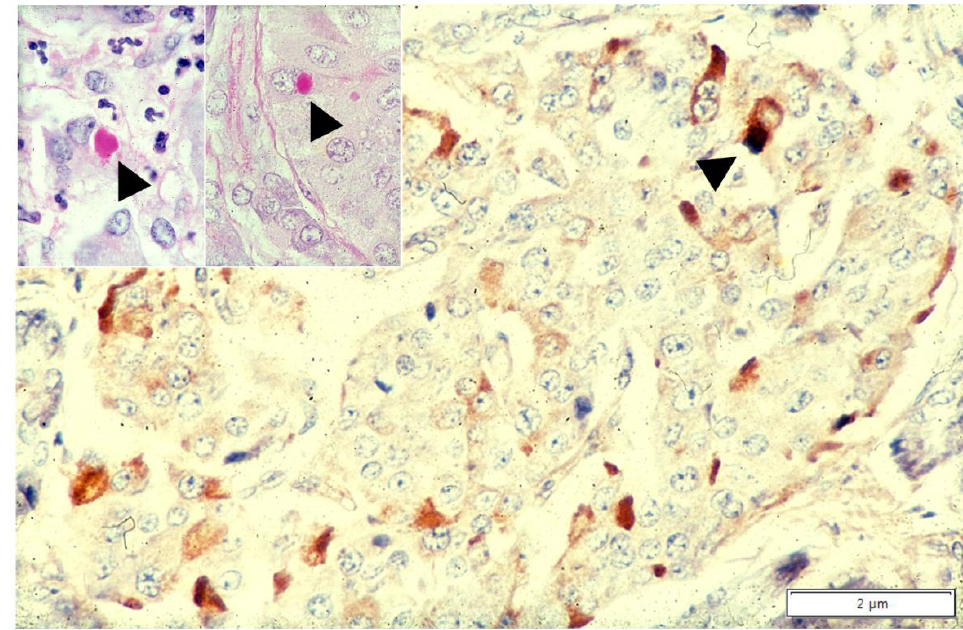
Figure 9. Pi ZZ cirrhotic patient. A pancreatic islet shows AAT positive cells mainly located at the periphery (immunostaining × 100). An islet cell (head arrow) contains a large AAT immunoreactive globule (arrow-head) corresponding to the PAS–D inclusion at the apical pole of the same cell (inset: arrowhead, PAS–D × 100)). An analogous inclusion is present in a hepatocyte surrounded by inflammatory cells, from the cirrhotic liver of the same patient (PAS–D, original magnification 100 ×